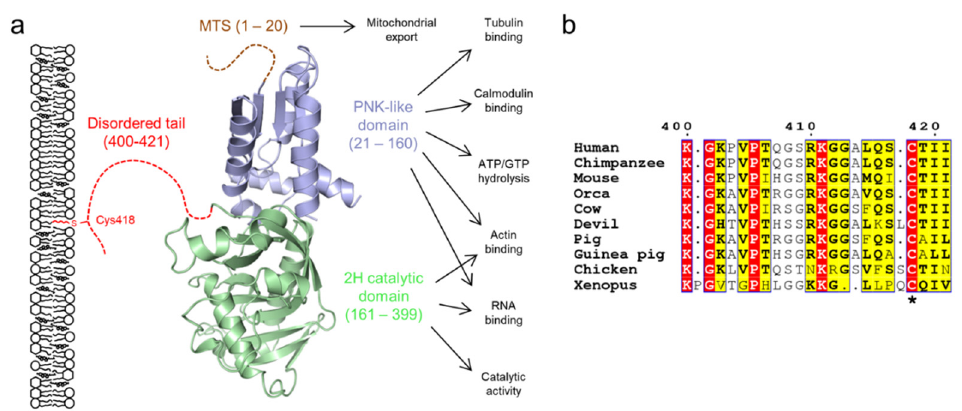
Figure 5. The domain structure of CNPase. ( a ) CNPase consists of two folded domains and a C-terminal 20-residue disordered tail, which mediates membrane interactions via the lipidated residue Cys418. Isoform 2 contains an additional N-terminal mitochondrial targeting sequence (MTS). The C-terminal tail tethers CNPase to the membrane, while it carries out its various functions [44,141]. ( b ) The C-terminal tail is conserved within several vertebrates, but is lost e.g. in fishes [141]. The lipidated Cys residue is indicated with an asterisk. Residue numbering corresponds to human CNPase. Orca, killer whale; Devil, Tasmanian devil; Xenopus, African clawed frog.